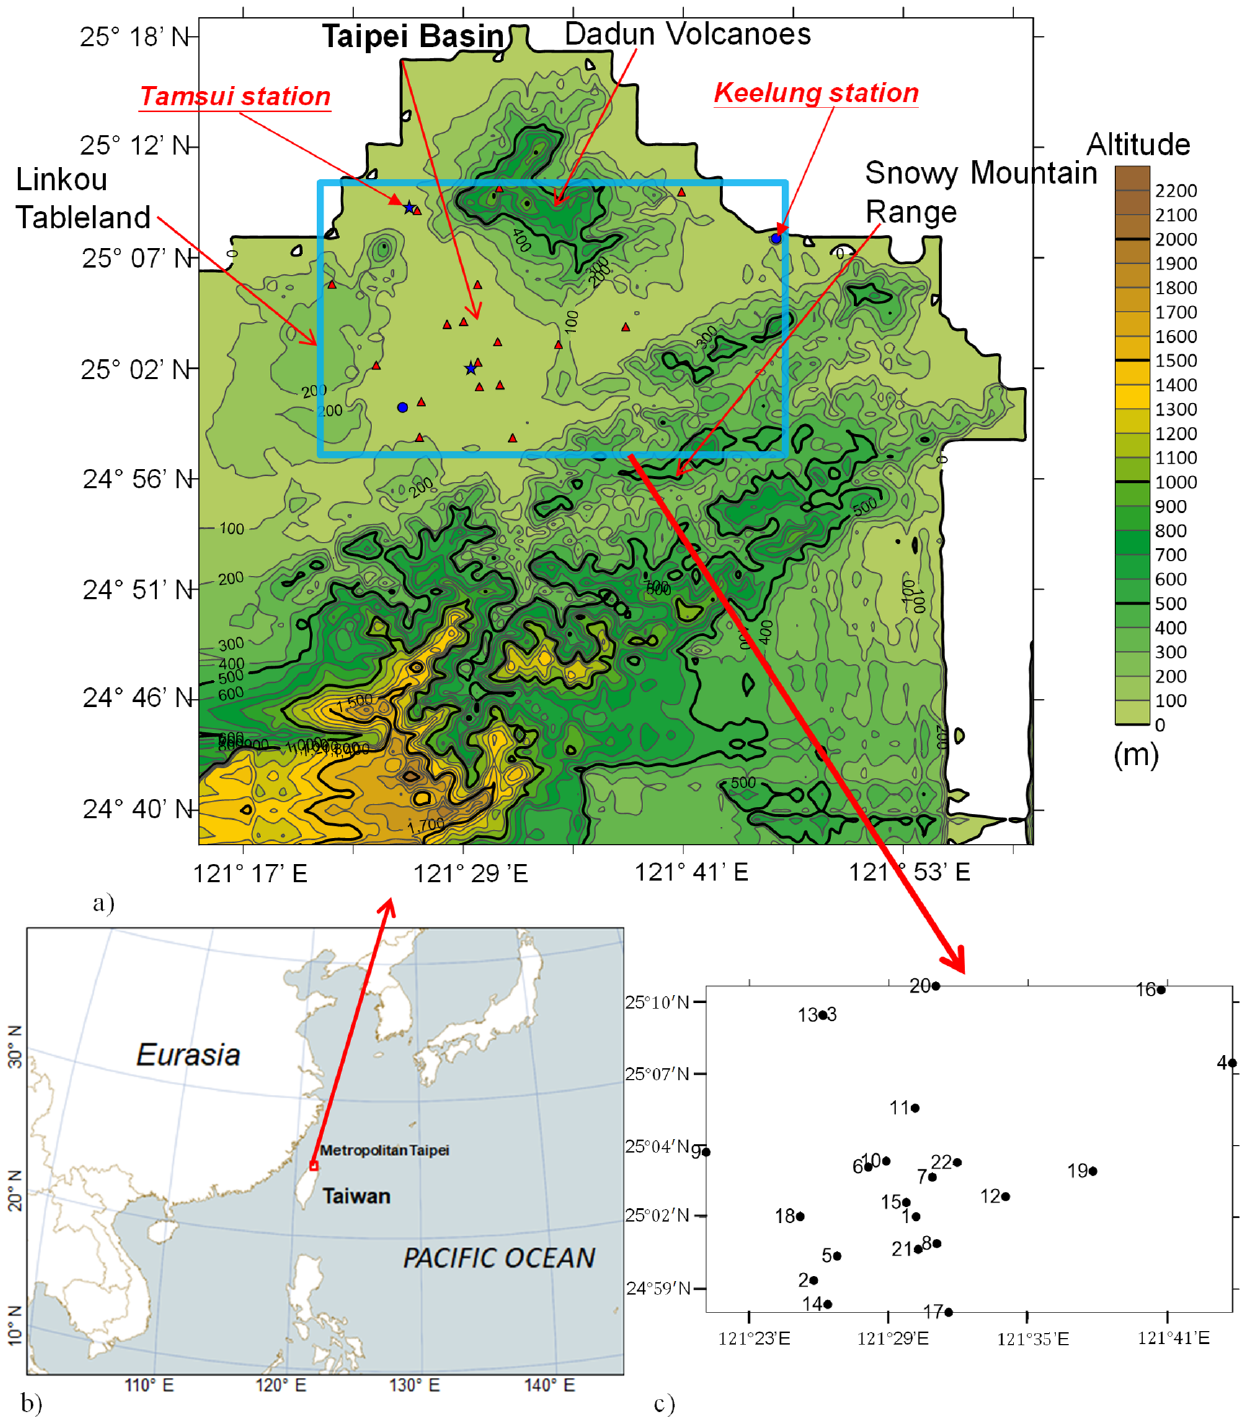
Figure 1. Taiwan geographical information: ( a ) terrain of the Taipei metropolis; ( b ) location of Taiwan and the Taipei metropolis; ( c ) distribution of the sites. The numbers of the sites are shown in Table 1. Blue circles and blue stars indicate the weather stations operated by the Central Weather Bureau, triangles indicate the air-quality monitoring stations operated by the Environmental Protection Administration, and blue stars indicate the urban and rural sites used to calculate the urban heat island index.